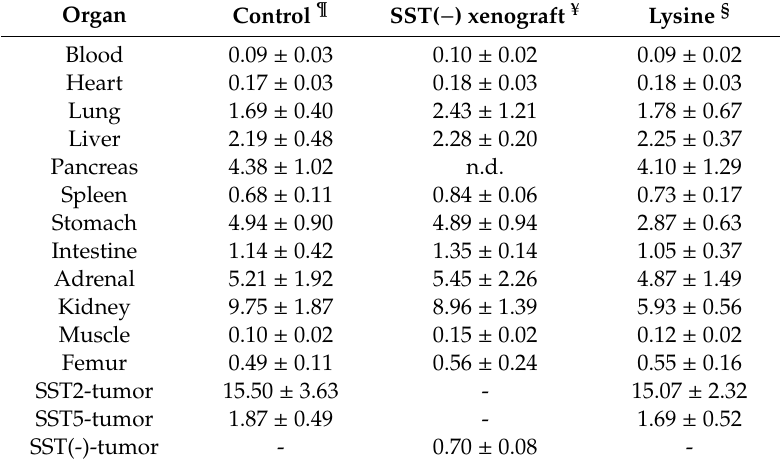
Table 4. Biodistribution results of [ 177 Lu]Lu-DOTA-ST8950, 4 h p.i. in SST-negative (SST( − )) tumor The results are expressed as mean of the % injected activity per gram of tissue (%IA / g) ± standard deviation